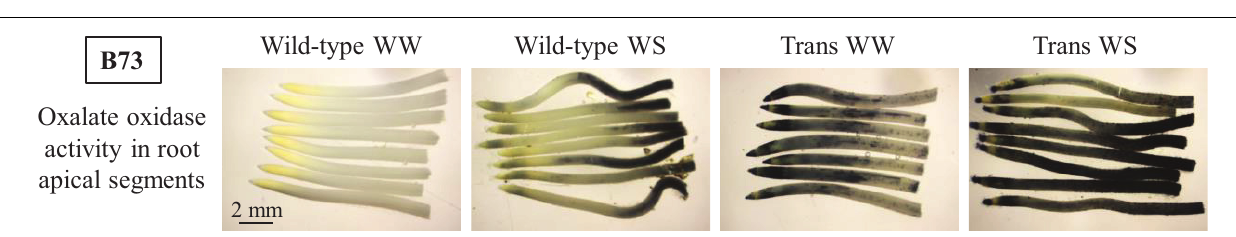
FIGURE 2 | Oxalate oxidase activity measured by oxidation of 4-chloro-1-naphthol, seen as dark blue staining, in approximately 12-mm apical segments of the primary root in the B73 oxalate oxidase transgenic (Trans) and wild-type lines at 48 h after transplanting to well-watered (WW) or water-stressed (WS; –1.6 MPa) conditions. The experiments were repeated with similar results and representative images are